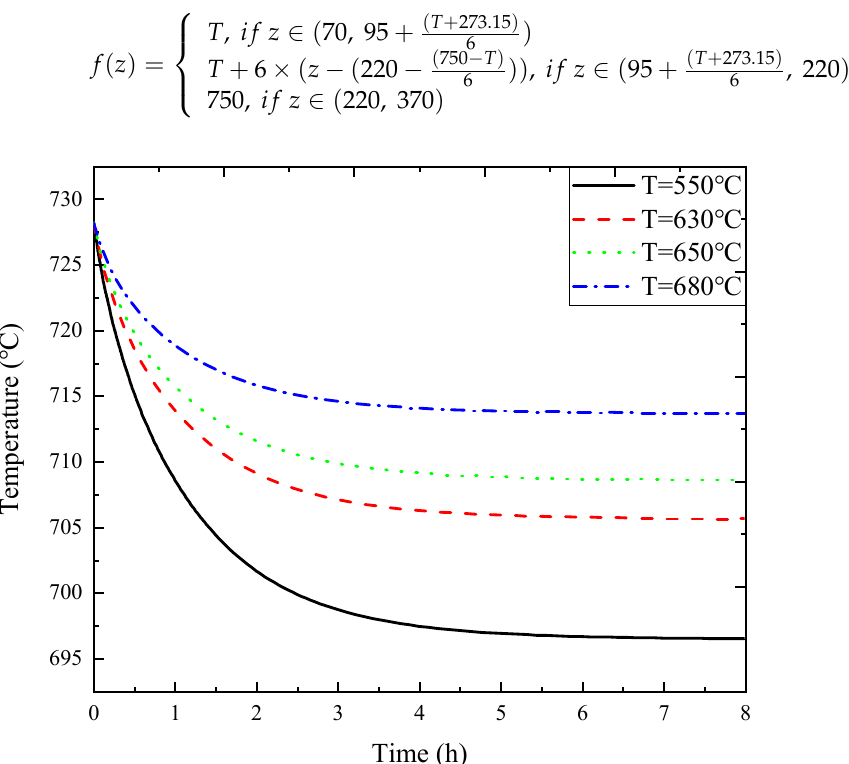
Figure 9. The temperature of LiH at the conical point during cooling of the lower furnace. The cone point is in a superheated state when the thermal balance is again reached, and the temperatures are, respectively, 696.5 ◦ C, 705.6 ◦ C, 708.6 ◦ C, and 713.7 ◦ C. All the temperatures are higher than the melting point of LiH, which is conducive to the subsequent temperature rise of the furnace. The cooling water will cause a large area of undercooling condensation if the crystal margin is too small, which would influence the quality of the LiH single crystal. For this reason, T should not be smaller than 550 ◦ C. The temperature at the furnace’s central axis is shown in Figure 10. The figure is divided into seven areas from left to right corresponding to the air gap, copper cooler, hydrogen gap, reactor, crucible, LiH, and hydrogen above the LiH, which fully shows the temperature distribution of the main structure in the furnace chamber. The lowest air gap is located in the upper third of the lower-temperature zone, and LiH is distributed